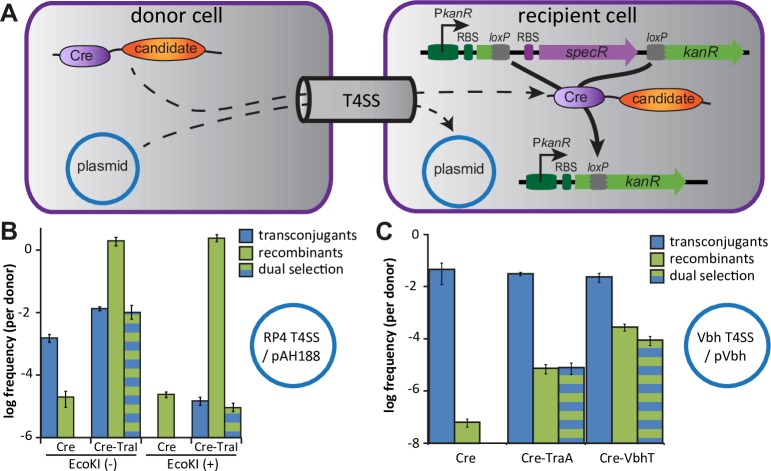
A novel variant of CRAfT detects the interbacterial transfer of VbhT.(A) The scheme outlines basic principles of the new CRAfT variant that we developed as part of this study. Interbacterial protein transfer of Cre fusions is detected through the switch from spectinomycin resistance (purple) to kanamycin resistance (green). Conjugative plasmid transfer can be assayed in parallel (blue) by selection for antibiotic resistance encoded on reporter plasmid pAH188 (chloramphenicol resistance; E. coli matings) or pVbh (gentamicin resistance; Bartonella matings). (B) Conjugative transfer of pAH188 and CRAfT signal for the translocation of a Cre-TraI relaxase fusion through the RP4 T4SS were assayed using E. coli K-12 BW25113 (lacking EcoKI) or E. coli K-12 MG1655 (with functional EcoKI) as recipients. (C) The transfer of Cre fused to the TraA relaxase of pVbh or the catalytically inactive H136A mutant of VbhT were tested in matings of B. schoenbuchensis with B. henselae carrying the CRAfT sensor module; conjugation of pVbh was assayed in parallel. Data points and error bars in (B) and (C) represent mean and standard deviation of three independent experiments. Transconjugants are recipient cells that have received pAH188 (B) or pVbh (C), and recombinants denote recipient cells that switched resistance of the CRAfT sensor due to successful transfer of Cre fusion proteins or, much rarer, spontaneous recombination of the loxP sites.